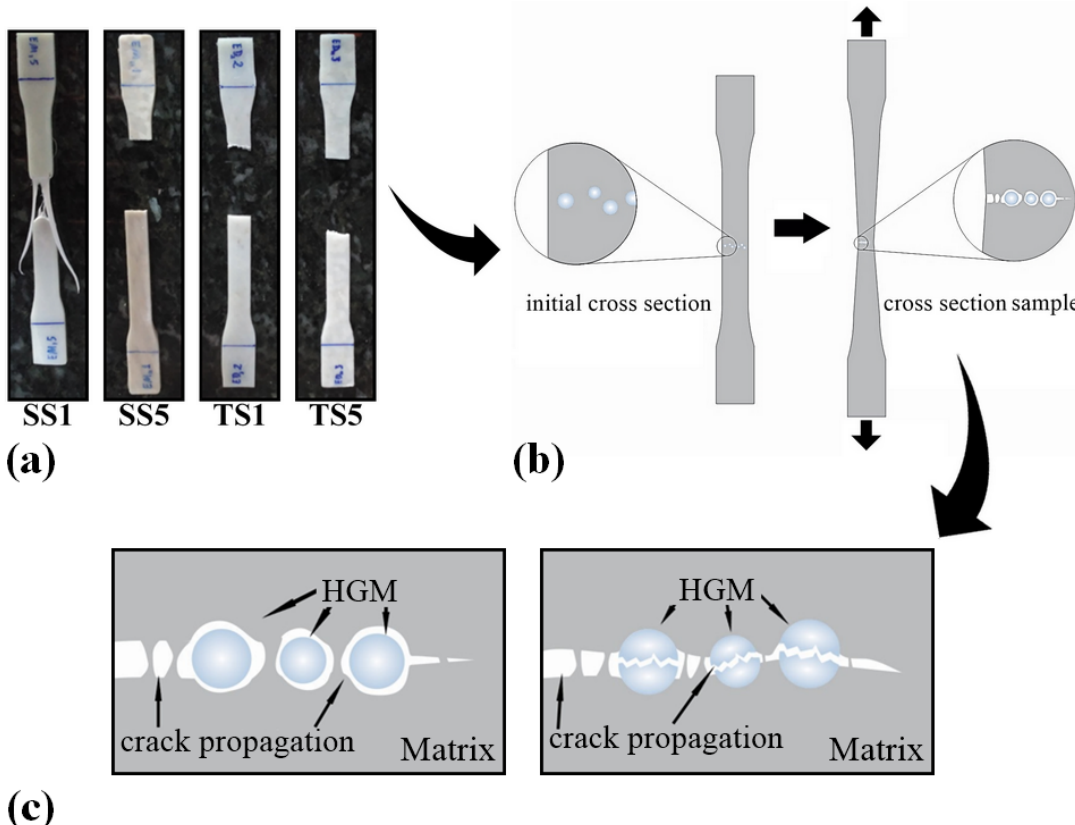
Figure 5. Illustration of the mechanism of crack propagation in syntactic foams: (a) Behavior of samples after tensile testing; (b) microspheres poorly adhered to the matrix and (c) microspheres adhered to the matrix.